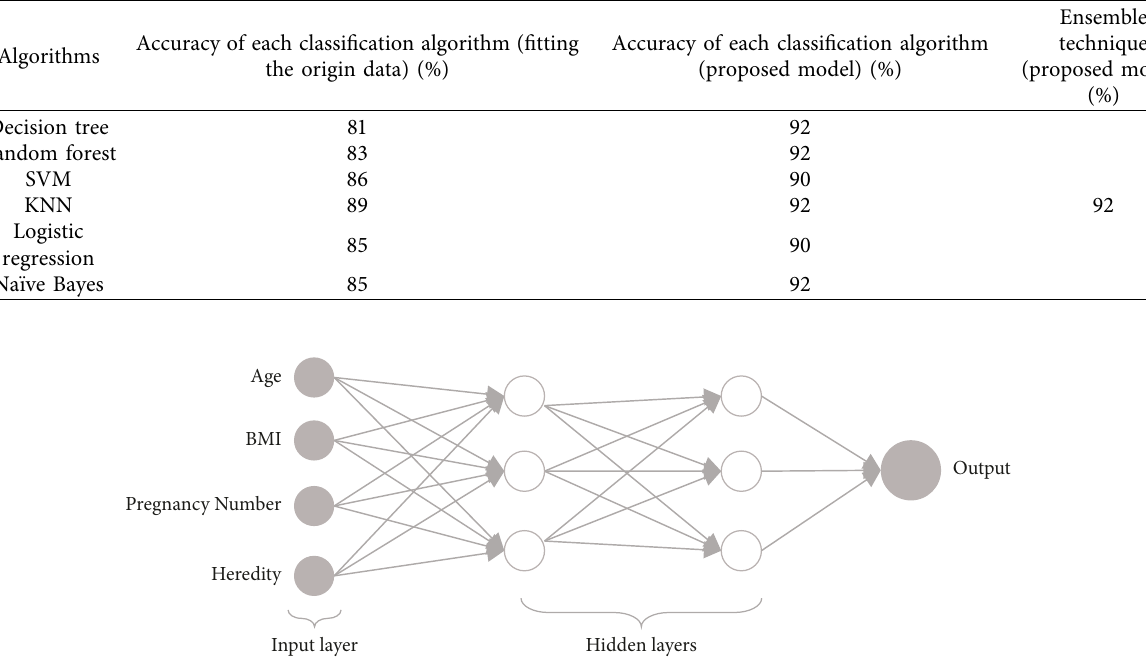
Figure 5: Decision-making by ensemble max voting Table 5: Classification accuracy and each technique of the proposed model comparison.